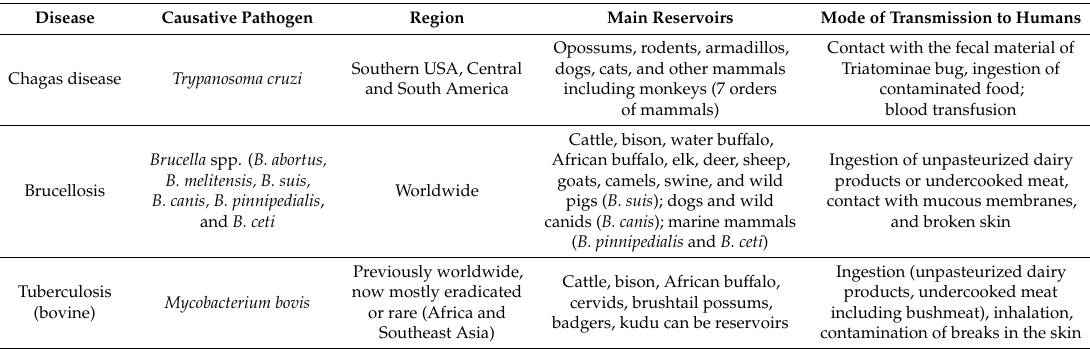
Table 1. Selected zoonoses reviewed